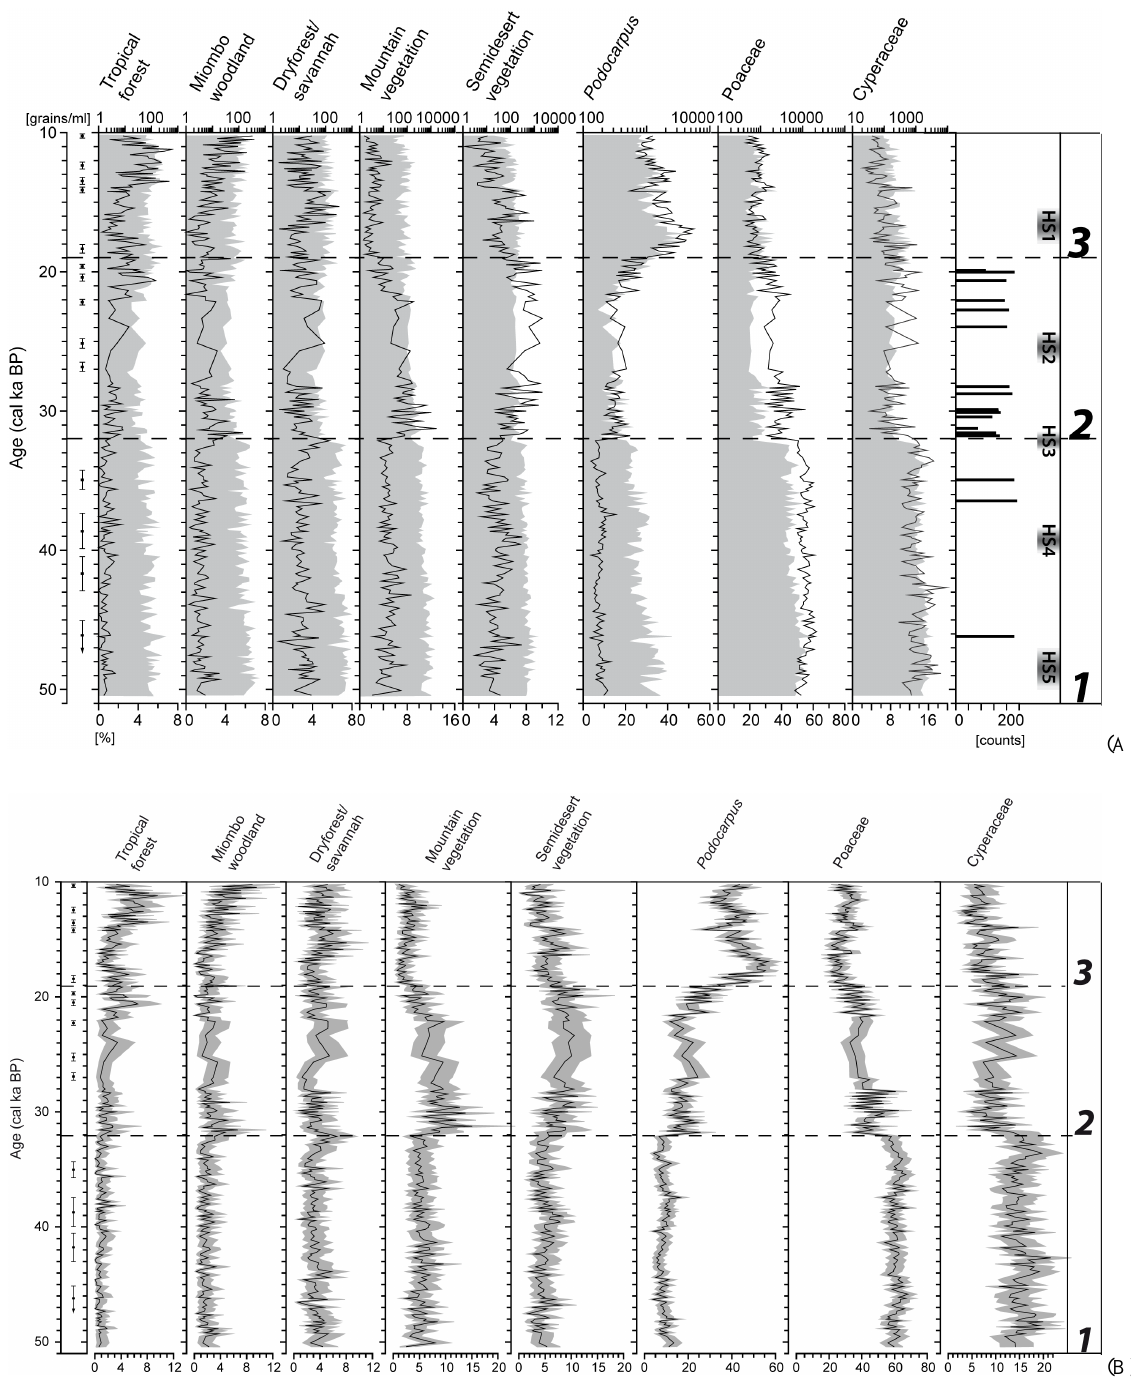
Figure 2A. Pollen percentages (black) and pollen concentrations of vegetation groups and selected pollen taxa (shaded). Concentrations are given in log10 grains/ml, note different scales. Timespans of calibrated C14 age (Kim et al., 2003; Rühlemann et al., 2004; Dupont et al., 2008) are indicated next to the time axis on the left hand side. On the right hand side samples with less than 250 pollen grains counted are indicated. Numbers indicate Pollenzones (PZ). PZ1 ranges from 50-32 ka BP, PZ2 from 32-19 ka BP, and PZ3 from 19-10 ka BP. Ages of Heinrich Stadials (HSs) are according to Sanchez-Goni and Harrison (2010): HS1 = 15.6- 18.0 ka BP, HS2 = 24.3-26.5 ka BP, HS3 = 31.3-32.7 ka BP, HS4 = 38.3-40.2 ka BP, HS5 =